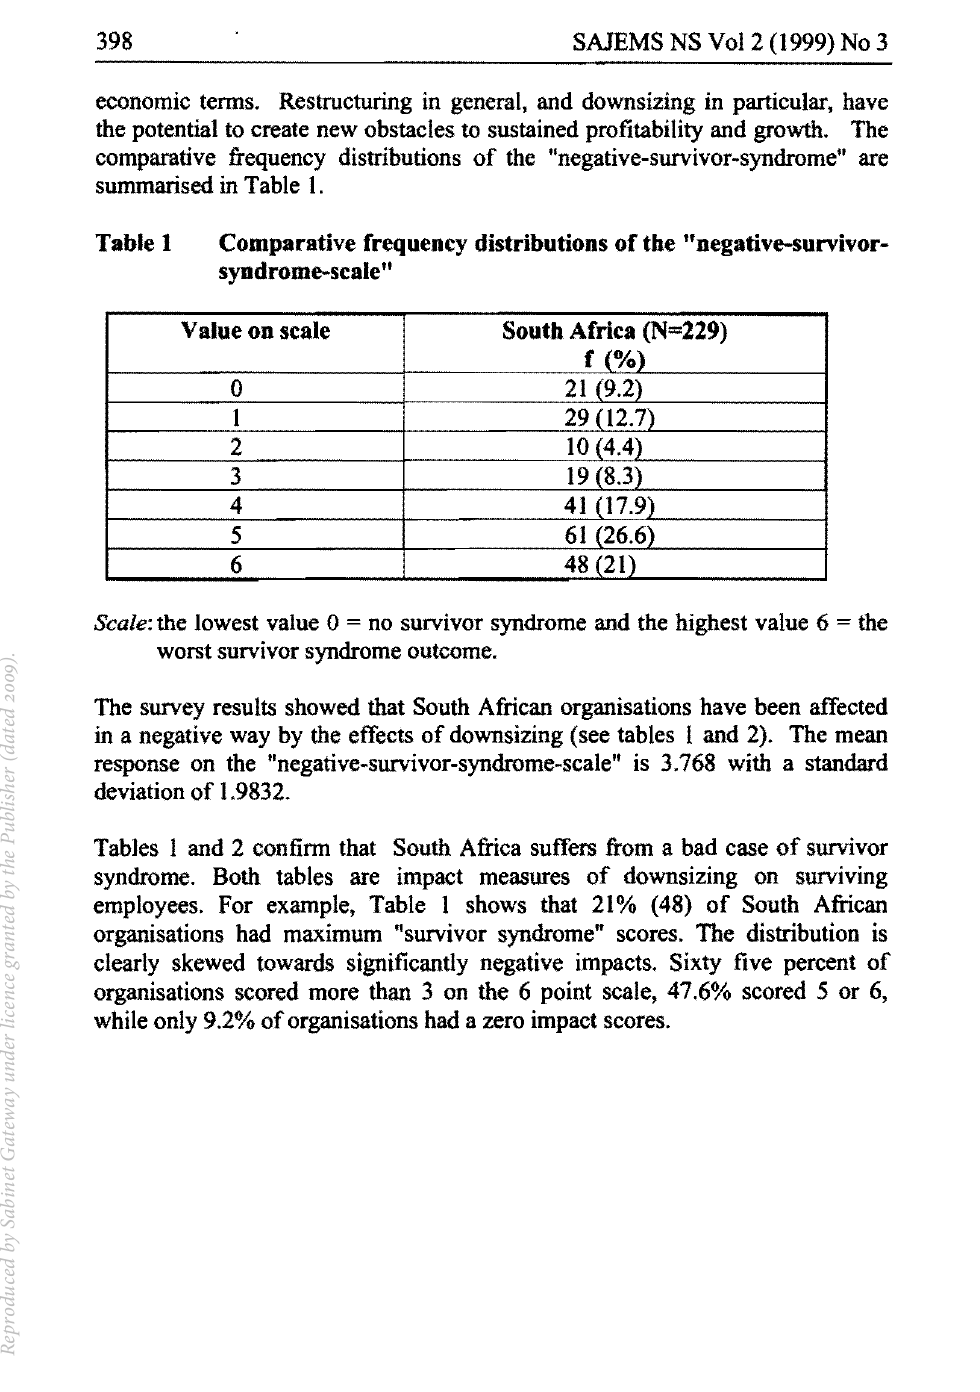
worst survivor syndrome